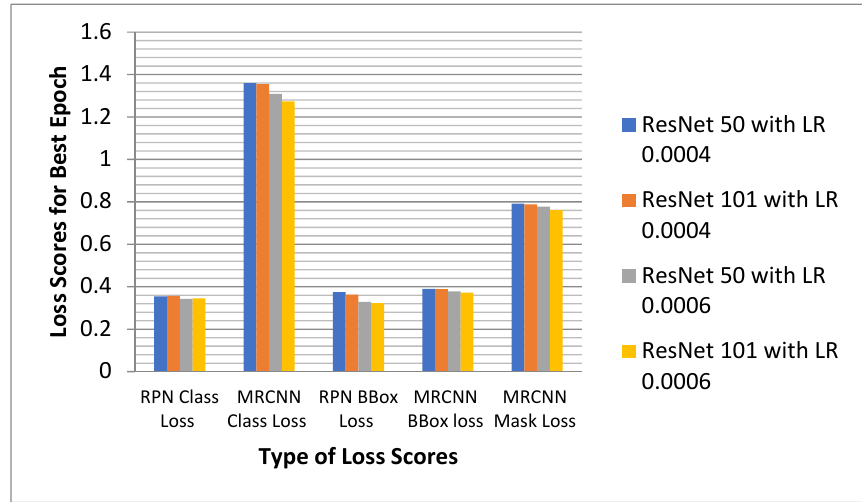
Figure 20. Comparative Analysis of ResNet101 and ResNet50 FPN for all type of losses.